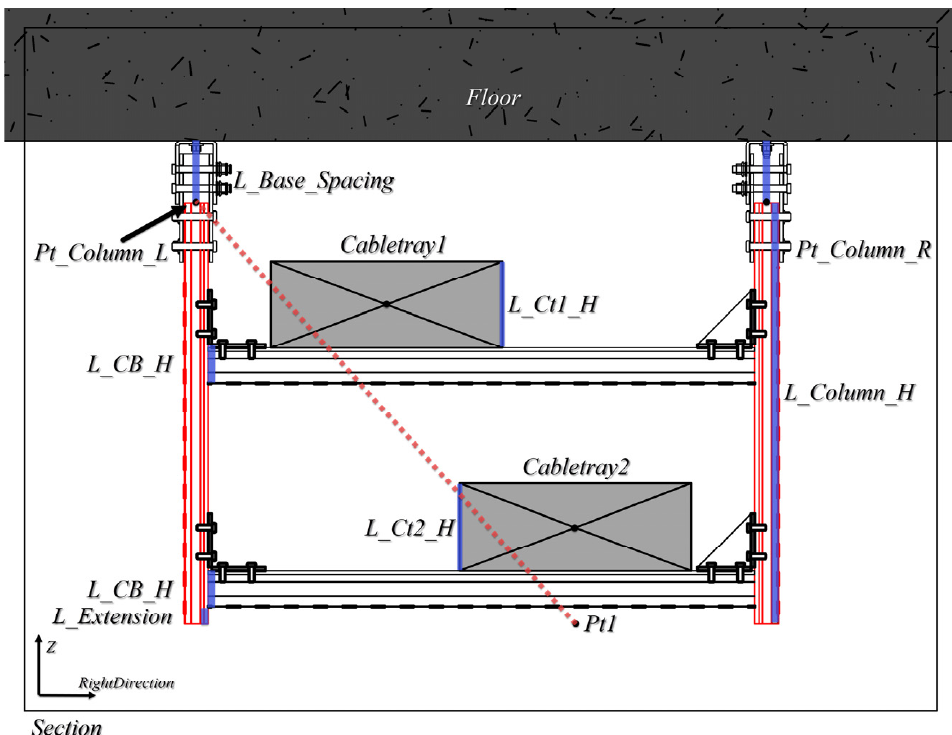
Figure 8. Schematic diagram of the calculation process of coordinates and length of the columns.